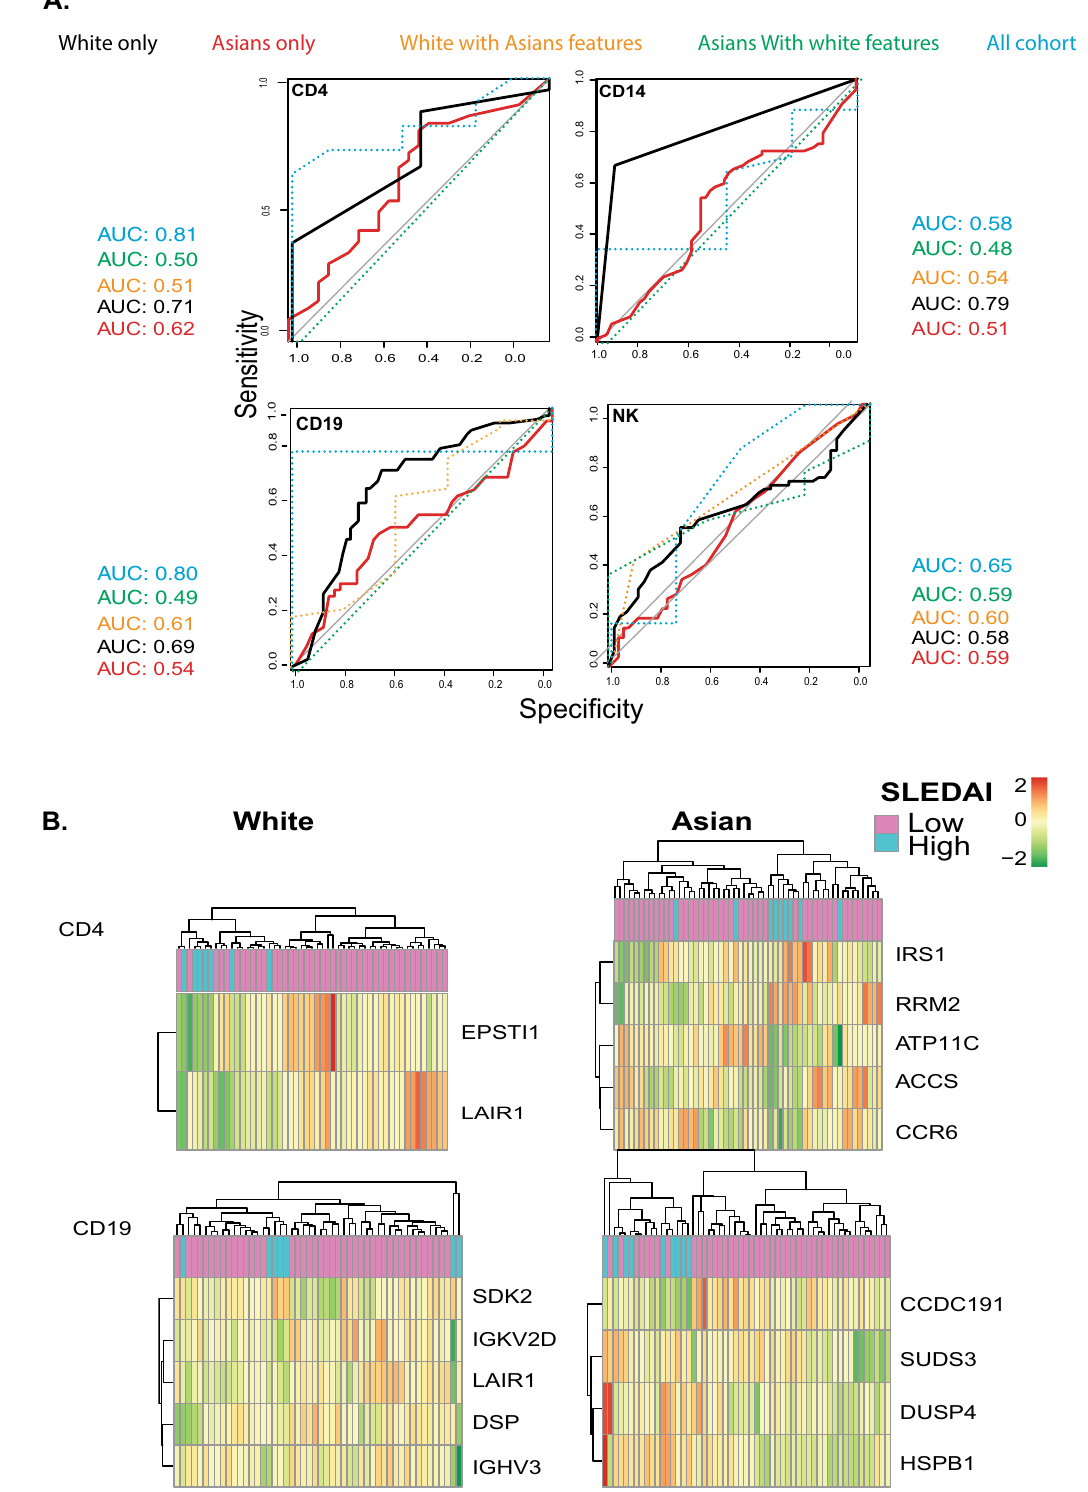
Fig. 6 Machine learning classi fi er. A Area under the ROC curve of machine learning classi fi er across the White and Asians data sets in discriminating active vs. inactive patients. White (black) and Asians (red) B Clustergram generated by using the expression values of the top predictors selected by FSelector